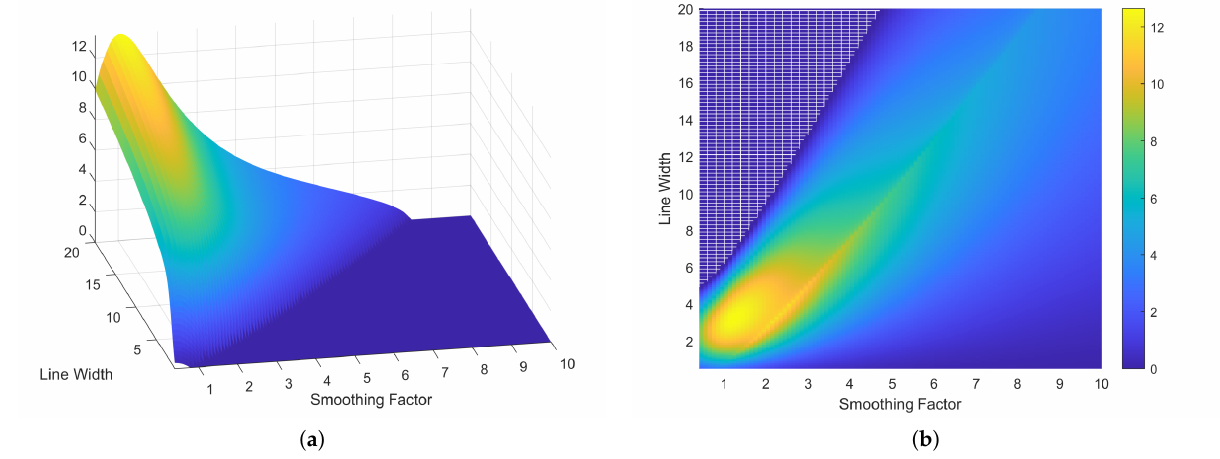
Figure 5. Comparison of SNRs of the ED-based and the SD-based line